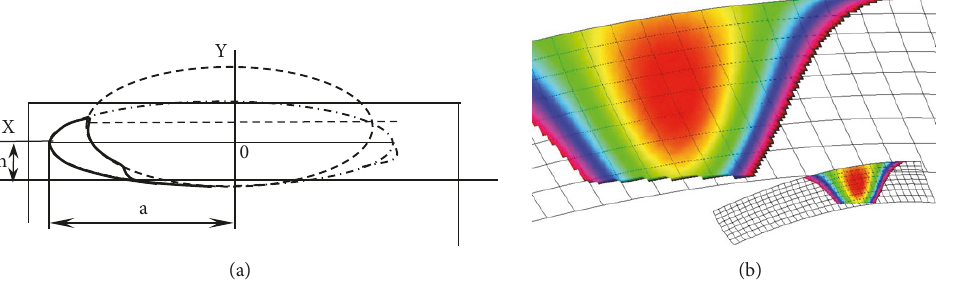
Figure 1: The spots of contact in Novikov’s gear: (a) unprocessed single gear line (SGL), model on Plexiglas [2], and (b) computer modeling [3, 4].